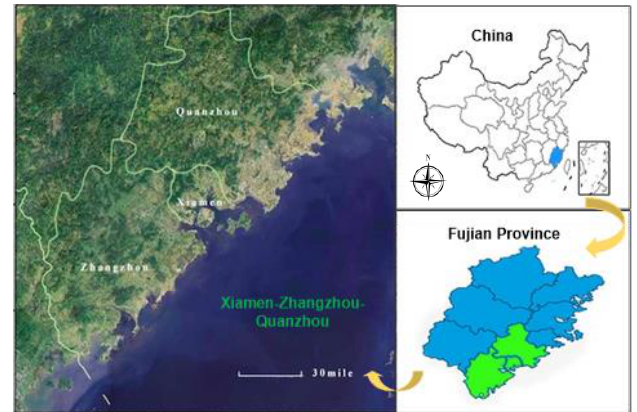
Figure 1. The study area.